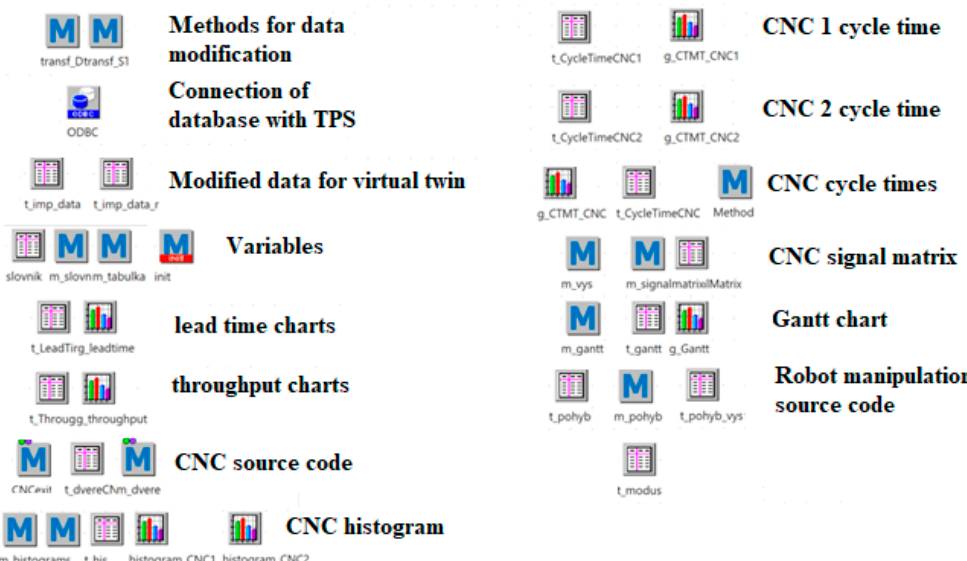
Figure 5. Source codes, methods and charts developed in the Tecnomatix Plant Simulation software.